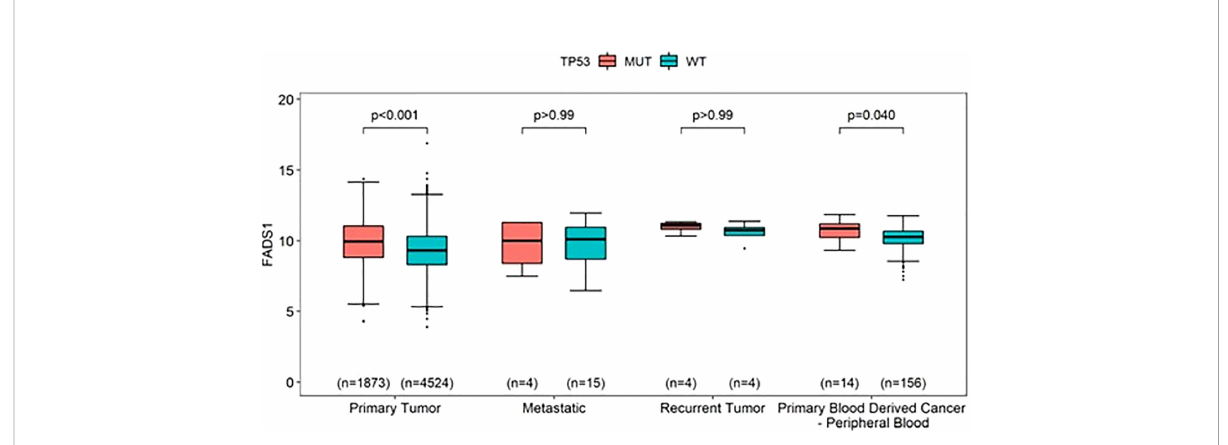
FIGURE 7 The mRNA expression levels of FADS1 according to sample type and TP53 ’ s mutation status (mutated [MUT] vs . wild-type [WT]) in all cancer types. The numbers in parentheses indicate the sample sizes and the p-values were obtained from post-hoc Wilcoxon-rank sum